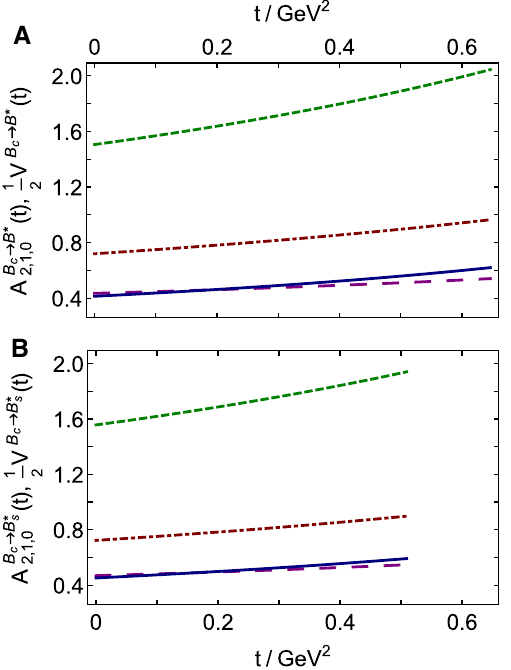
Fig. 8 A SCI predictions for B c → B ∗ transition form factors: A 2 ( t ) – dot-dashed red curve; A 1 ( t ) – long-dashed purple curve; A 0 ( t ) – solid V ( t ) –dashedgreencurve. B SCIpredictionsfor B c → B ∗ s bluecurve; 1 2 transition form factors, with legend as in A